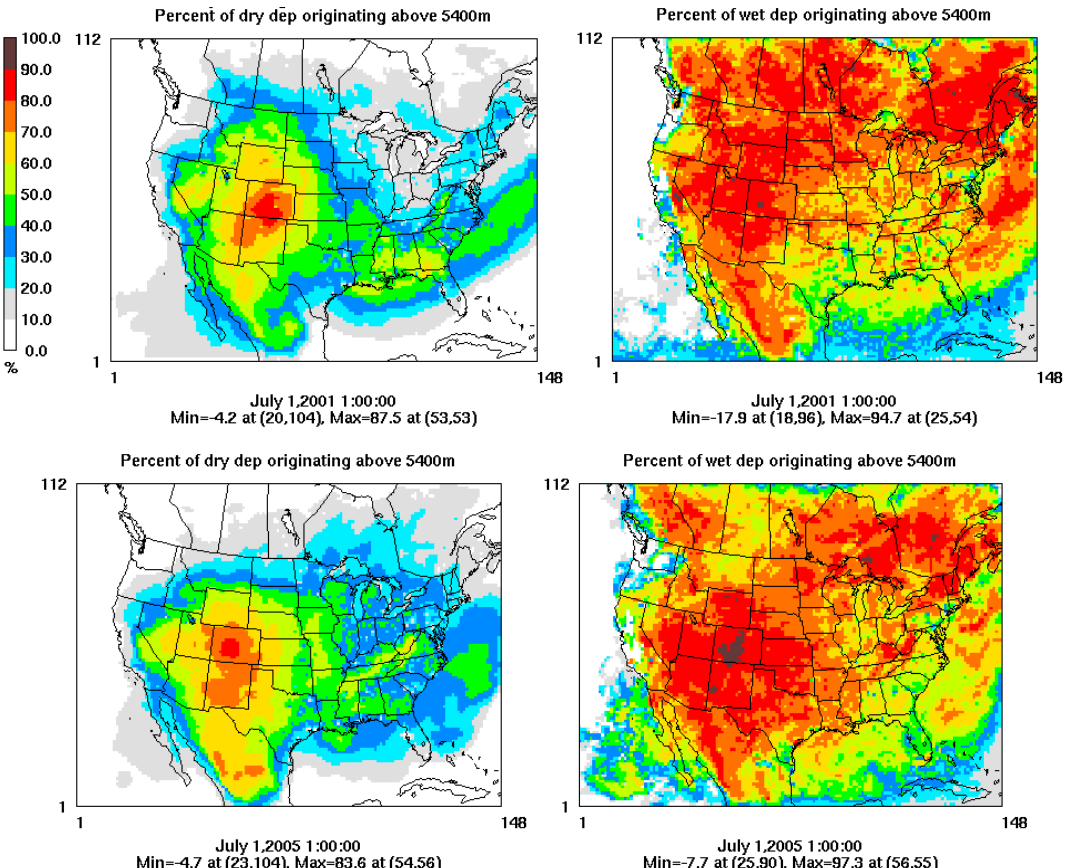
Fig. 8. Simulated percent contribution of mercury originating from boundary concentrations above 5400m for dry and wet mercury deposi- tion using both 2001 and 2005